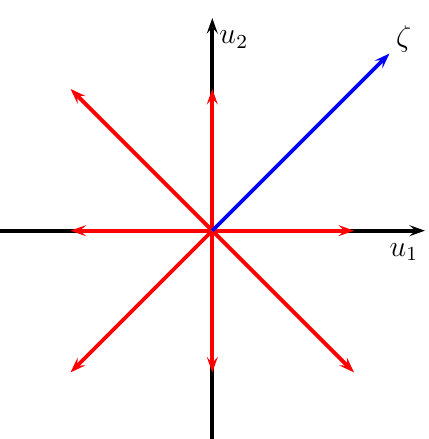
Figure 17. An auxiliary vector ζ for the JK-residue calculation of two-string elliptic genus of the G 2 gauge theory with one fundamental